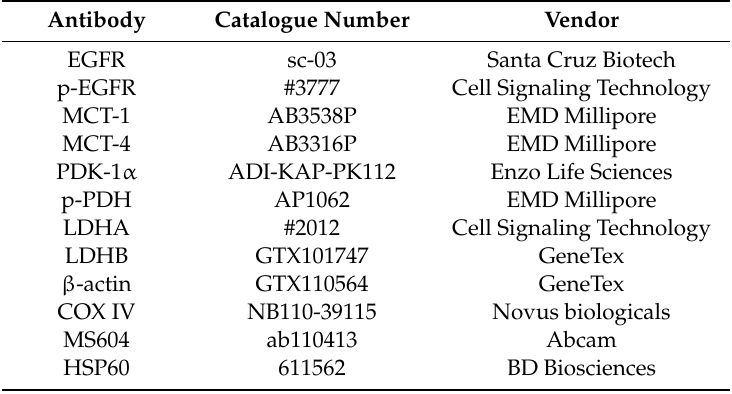
Table 1. Antibodies used in the